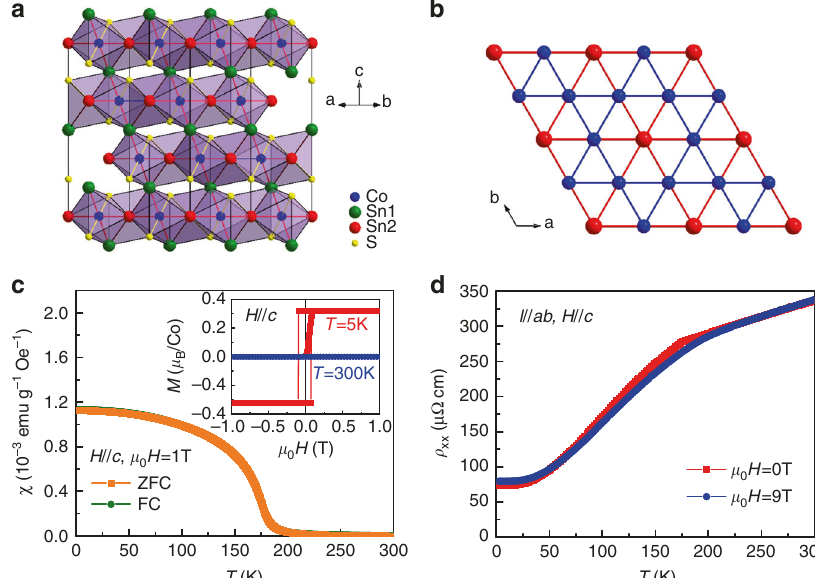
Fig. 1 Structure, magnetization and longitudinal resistivity of Co 3 Sn 2 S 2 . a , b Crystal structure of Co 3 Sn 2 S 2 and kagome layer made of Co atoms. The small blue and yellow balls represent Co and S atoms, respectively, and the big green and red balls represent Sn atoms at Sn 1 and Sn 2 sites, respectively. c Temperature dependence of magnetic susceptibility χ ( T ) with ZFC and FC modes at μ 0 H = 1 T for H || c . Inset: fi eld dependence of magnetization M ( μ 0 H ) at 5 and 300 K for H || c . d Longitudinal resistivity ρ xx ( T , μ 0 H ) as a function of temperature T at μ 0 H = 0 and 9 T along the c